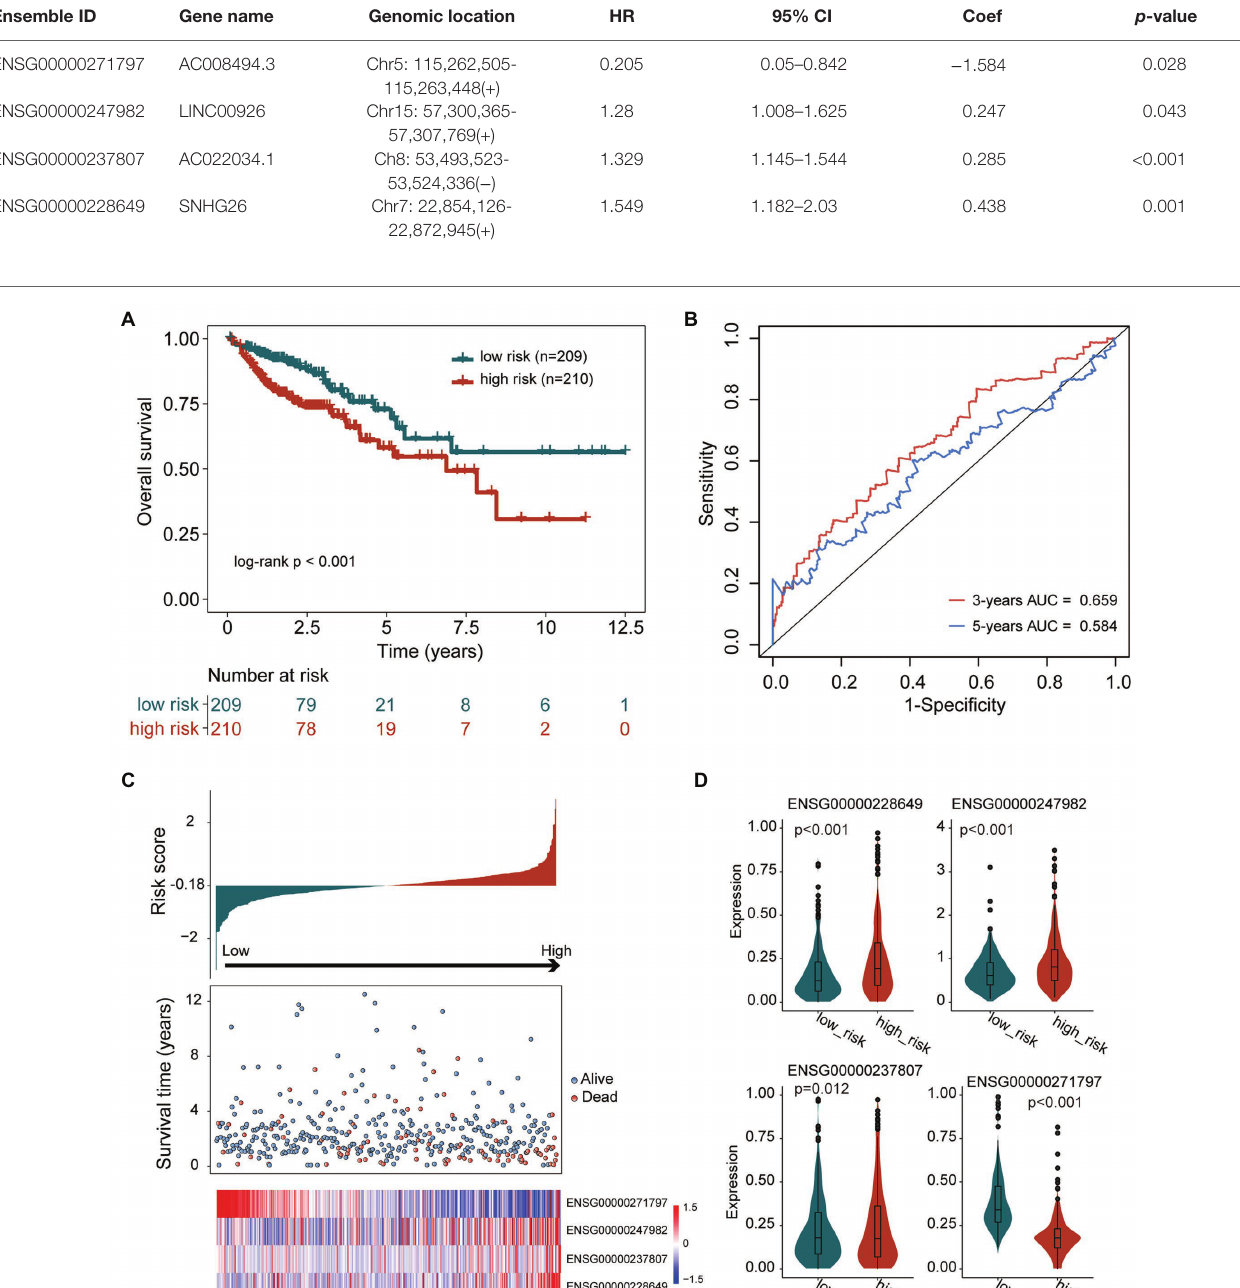
TABLE 1 | The detailed information of four prognostic tumor immune infiltration-associated lncRNAs in colon cancer.